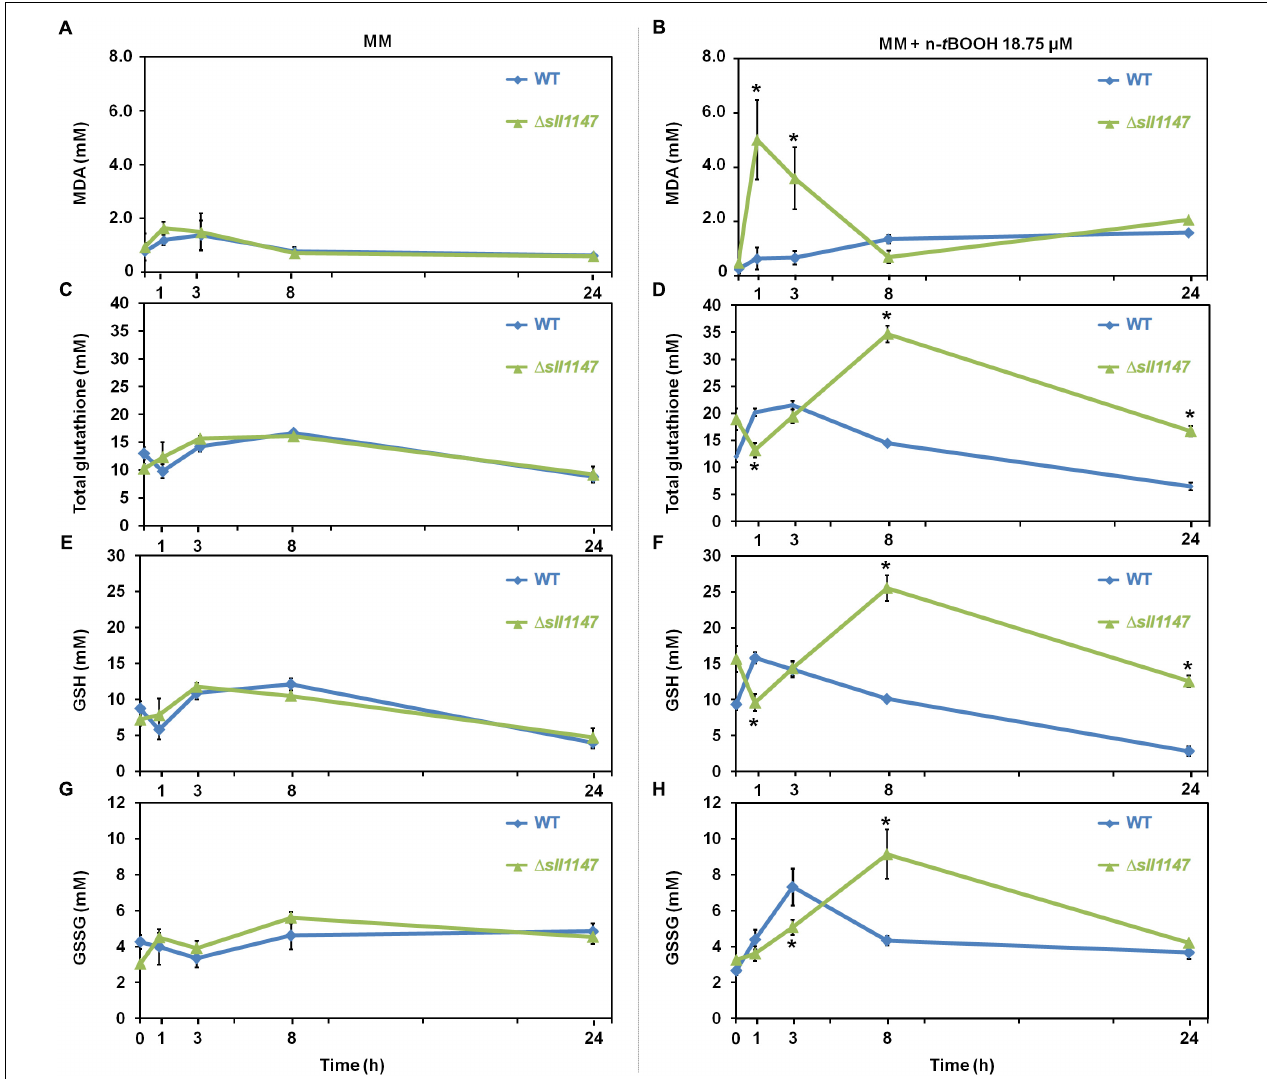
FIGURE 3 | The (cid:49) sll1147 sensitive mutant challenged by n- t BOOH, transiently accumulates peroxidized lipids and then glutathione. Kinetic analysis of the influence of n- tert butyl hydroperoxide (n- t BOOH) on the abundance of peroxidized lipids, measured as the MDA content (A,B) , total glutathione (C,D) , GSH (E,F) , and GSSG (G,H) in Synechocystis WT and (cid:49) sll1147 cells. The data are expressed as the mean ± SD of three assays and ∗ indicates significant difference between mutant and WT ( t -test, P < 0.05).